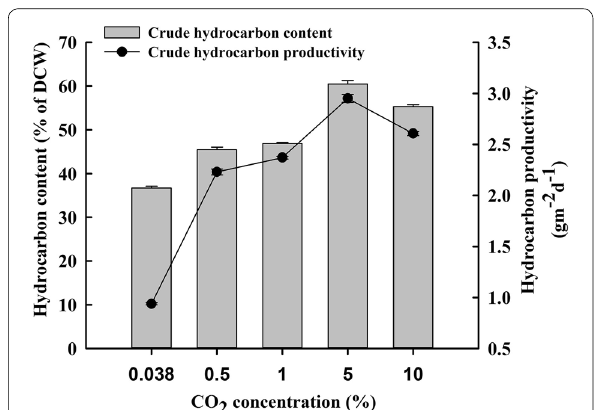
Fig. 4 Effect of CO 2 concentration on hydrocarbon accumula‑ tion of B. braunii SAG807‑1 under attached cultivation. Data are means standard deviations of three replicates ±